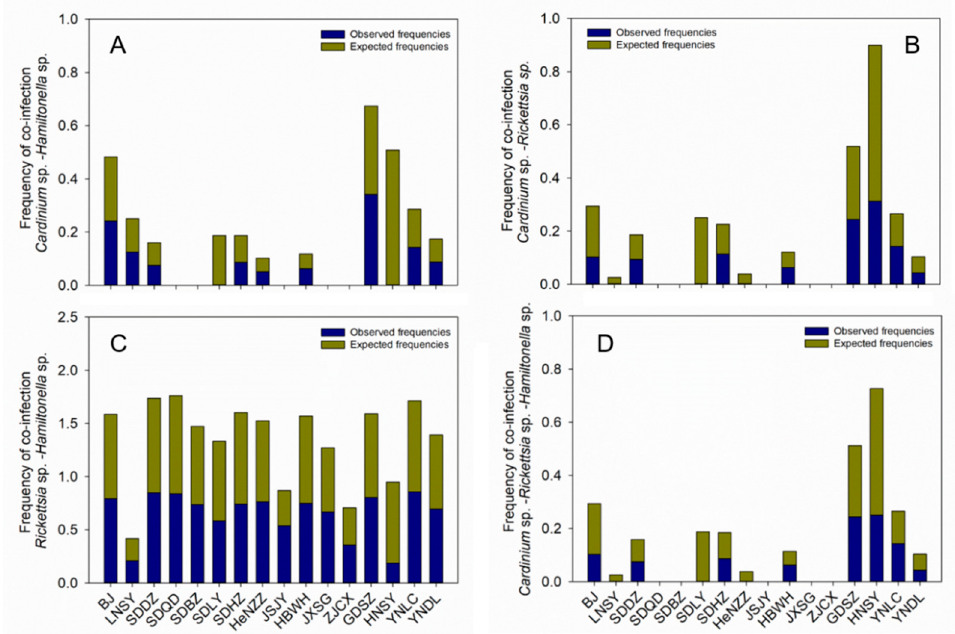
Figure 6. Expected frequency of coinfection based on observed frequencies in each sample. ( A ) Cardinium sp.– Hamiltonella sp., ( B ) Cardinium sp.– Rickettsia sp., ( C ) Rickettsia sp.– Hamiltonella sp., ( D ) Cardinium sp.– Rickettsia sp.– Hamiltonella sp.